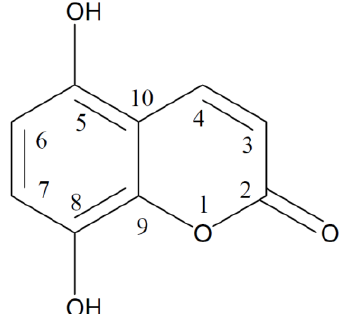
Figure 1. Chemical structure of